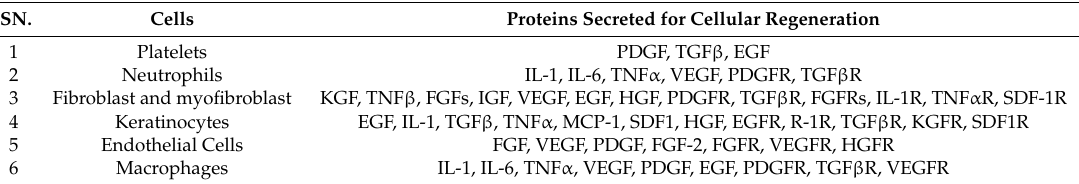
Table 1. Cells directly involved in wound healing